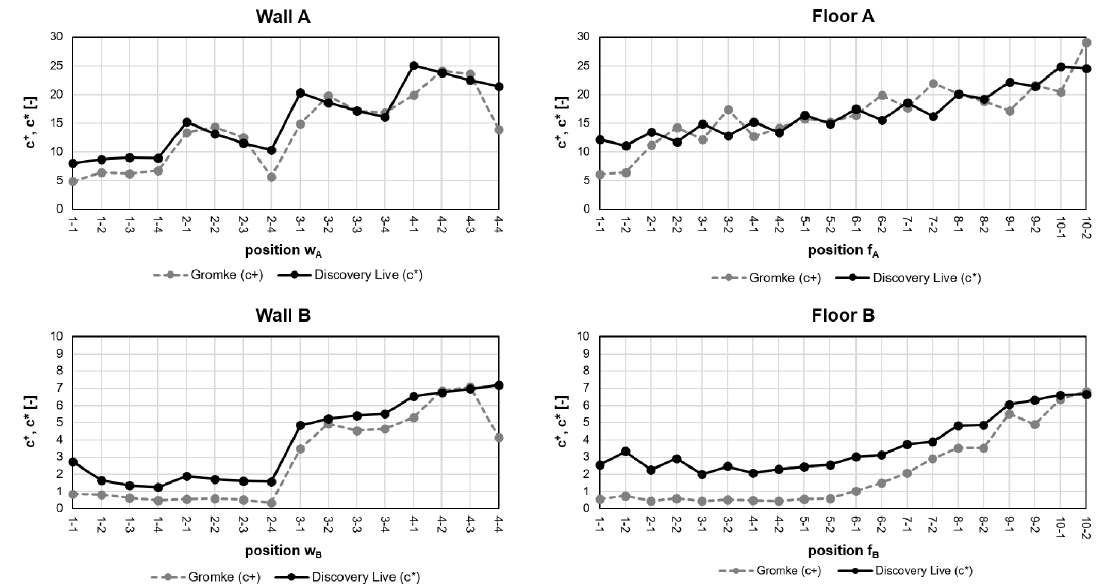
Figure 11. Comparison of the normalized concentration results from the wind tunnel experiment and the Discovery Live simulation data. Sampling positions are as defined by Gromke et al. [19].